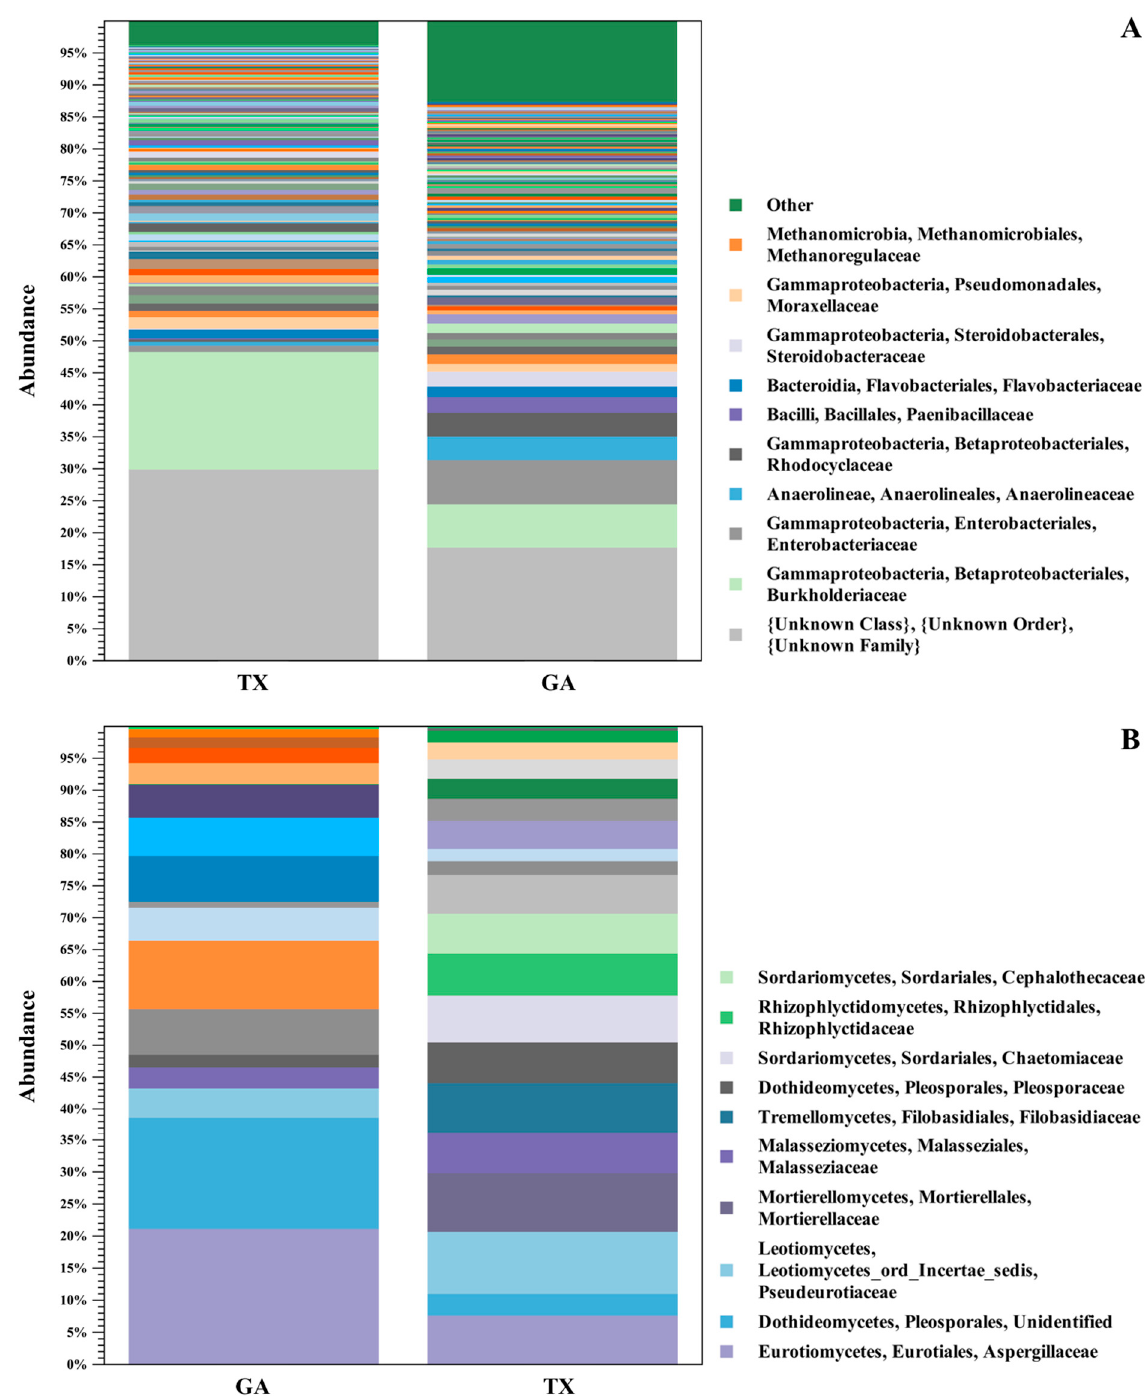
Figure 1. 16S and ITS OTU Clustering. Relative abundance of bacterial ( A ) and fungal ( B ) populations in seedlings of pecan grown from seed of the same controlled ‘Lakota’ × ‘Oaxaca’ cross from trees in Texas (TX) and Georgia (GA). The stacked bar chart shows OTU clustering at the level of taxonomic family of the bacterial and fungal microbial communities associated with the seedlings from the Georgia and Texas seed samples.